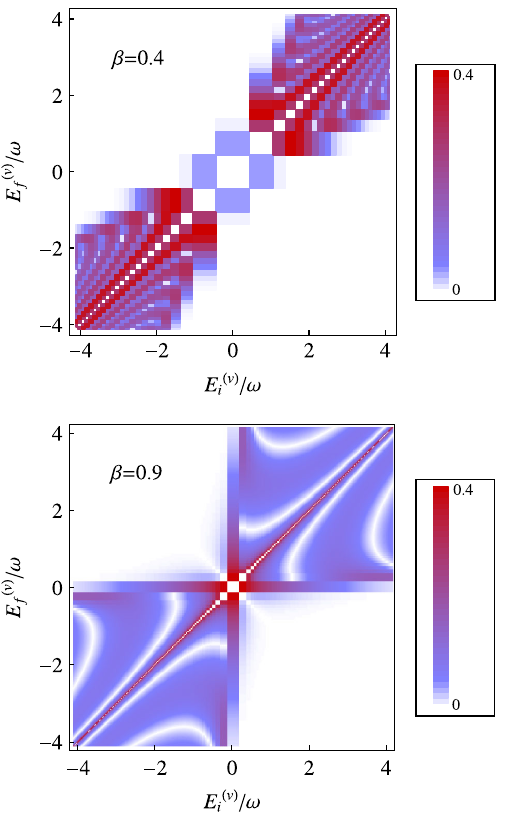
FIG. 7. Color-scale plots of the impurity-induced transition j in Born approximation [cf. Equation (54)] amplitudes j T ð 1 Þ fi as function of initial state i and final-state f , for velocities (cid:9) ¼ 0 : 05 , 0.4, and 0.9. The dashed lines indicate an estimate for the onset of the Gaussian suppression and are given by f ¼ ð 1 (cid:6) (cid:9) Þ 2 = ð 1 (cid:2) (cid:9) Þ 2 i (see main